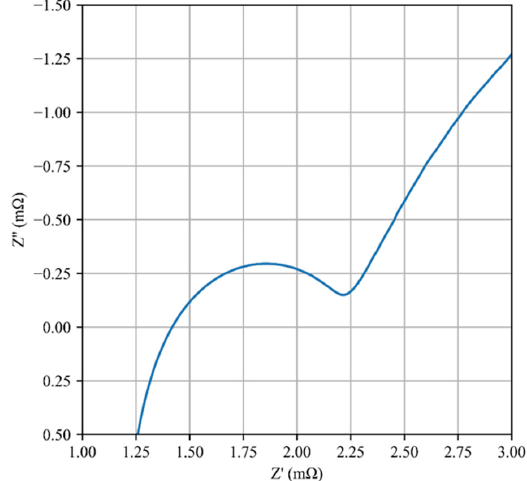
Figure 12. Typical Nyquist diagram of LTO/LMO cell at room